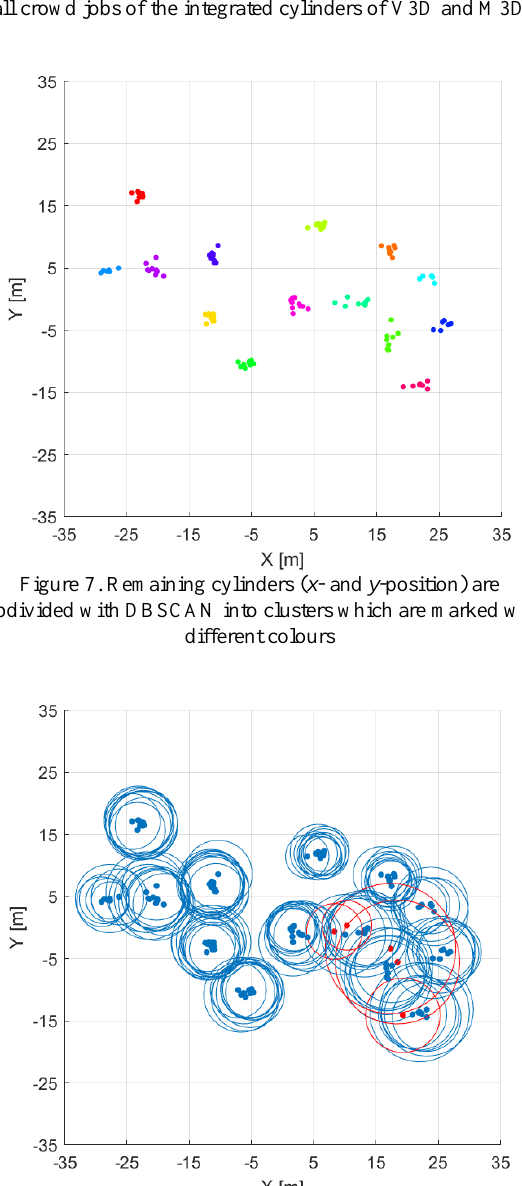
Figure 8. Further outlier detection based on the evaluation of the heights and the radius of the cylinders (cylinders in bird view)